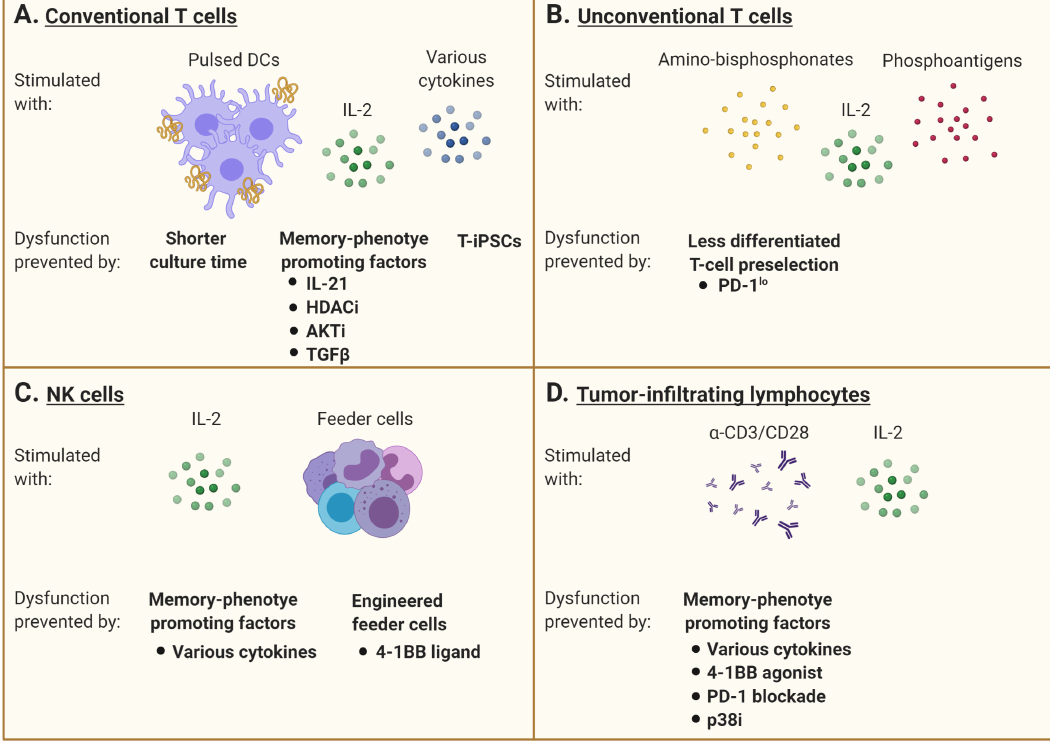
Figure 2. Interventions aiming at limiting T-cell dysfunction for adoptive immunotherapy. ( A ) Conventional αβ T cells are generally stimulated with specific peptides that may be presented by professional antigen-presenting cells such as dendritic cells (DCs) and supported by IL-2 supplementation and/or other cytokines. However, repetitive or chronic antigen stimulation promotes the gradual accumulation of dysfunctional cells over time. Many interventions are under investigation to maintain the cells in a less differentiated state. A shorter culture time allows for the maintenance of a higher percentage of healthy cells, but this may limit the number of cells manufactured. The addition of various factors to promote a memory phenotype differentiation is also evaluated, including the use of IL-21, TGF β , histone deacetylase (HDAC) inhibitors, or AKT inhibitors. The rejuvenation of dysfunctional T cells by induced pluripotent stem cell technology can also generate less differentiated cells. ( B ) Unconventional γδ T cells are stimulated with amino-bisphosphonates and phosphoantigens, combined with IL-2. The pre-selection of T cells with a favorable phenotype, excluding cells expressing inhibitory receptors such as PD-1, has been investigated to limit the development of dysfunctional features. ( C ) Natural killer (NK) cells are mainly activated with IL-2 and feeder cells. Supplementation with various cytokines or agonists of co-stimulatory molecules (e.g., 4-1BB) can shape their differentiation status and modulate their receptor expression pattern. The engineering of feeder cells as well as the NK cells themselves to express these factors is also underway. ( D ) Tumor-infiltrating lymphocytes are stimulated with anti-CD3 with or without anti-CD28, with IL-2 supplementation. As for conventional T cells, the addition of various cytokines can promote a memory phenotype differentiation. The combination of a 4-1BB agonist and PD-1 blockade can also prevent the development of dysfunction. Inhibition of p38MAPK signaling has further shown to limit development of senescence features. This figure was created with